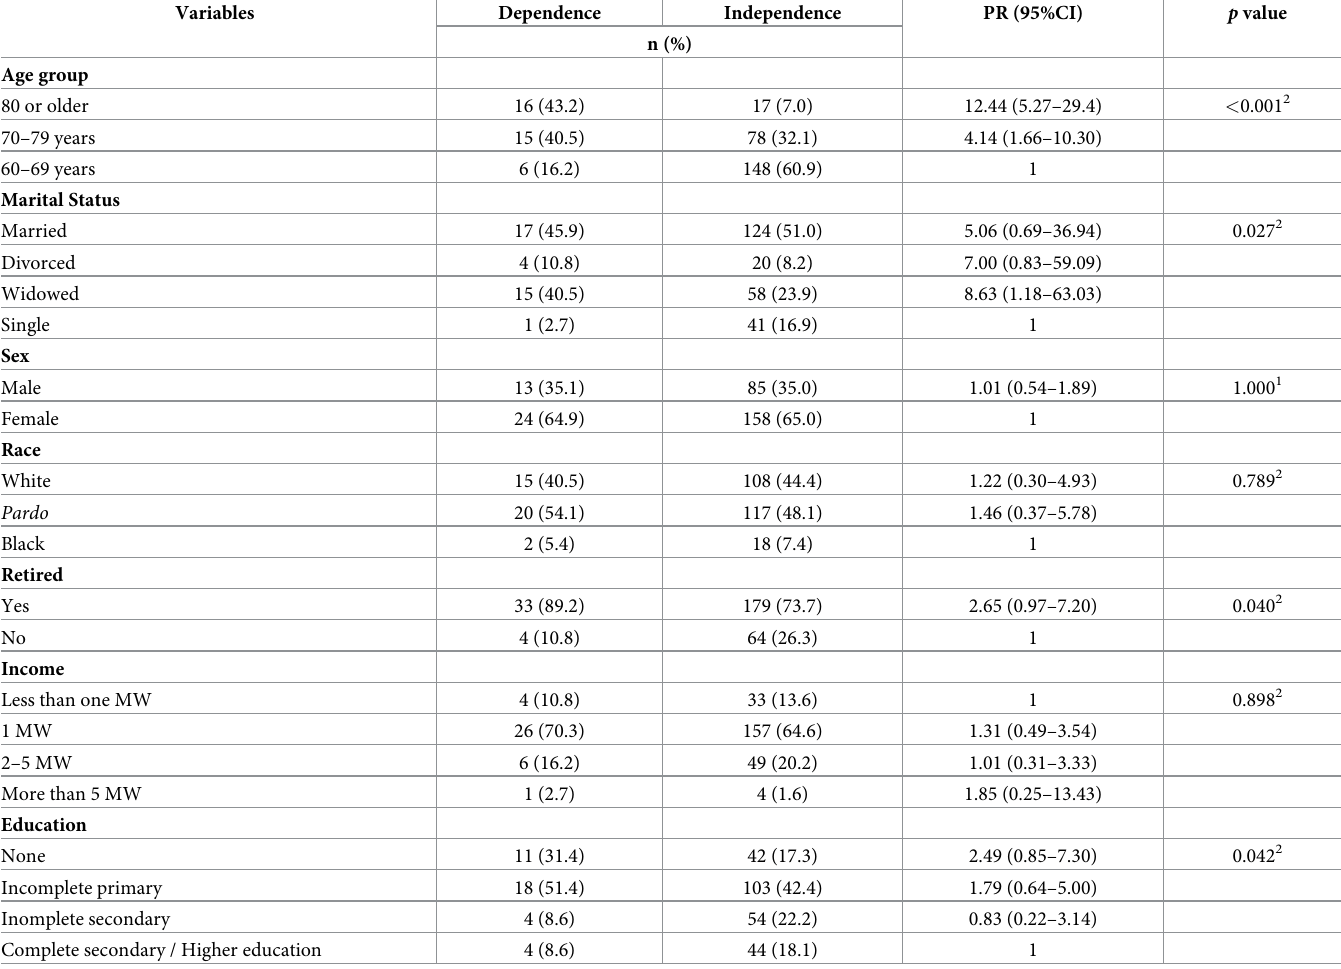
Table 1. Frequency distribution and inferential analysis of older people’s sociodemographic data versus dependence and independence in instrumental activities of daily living